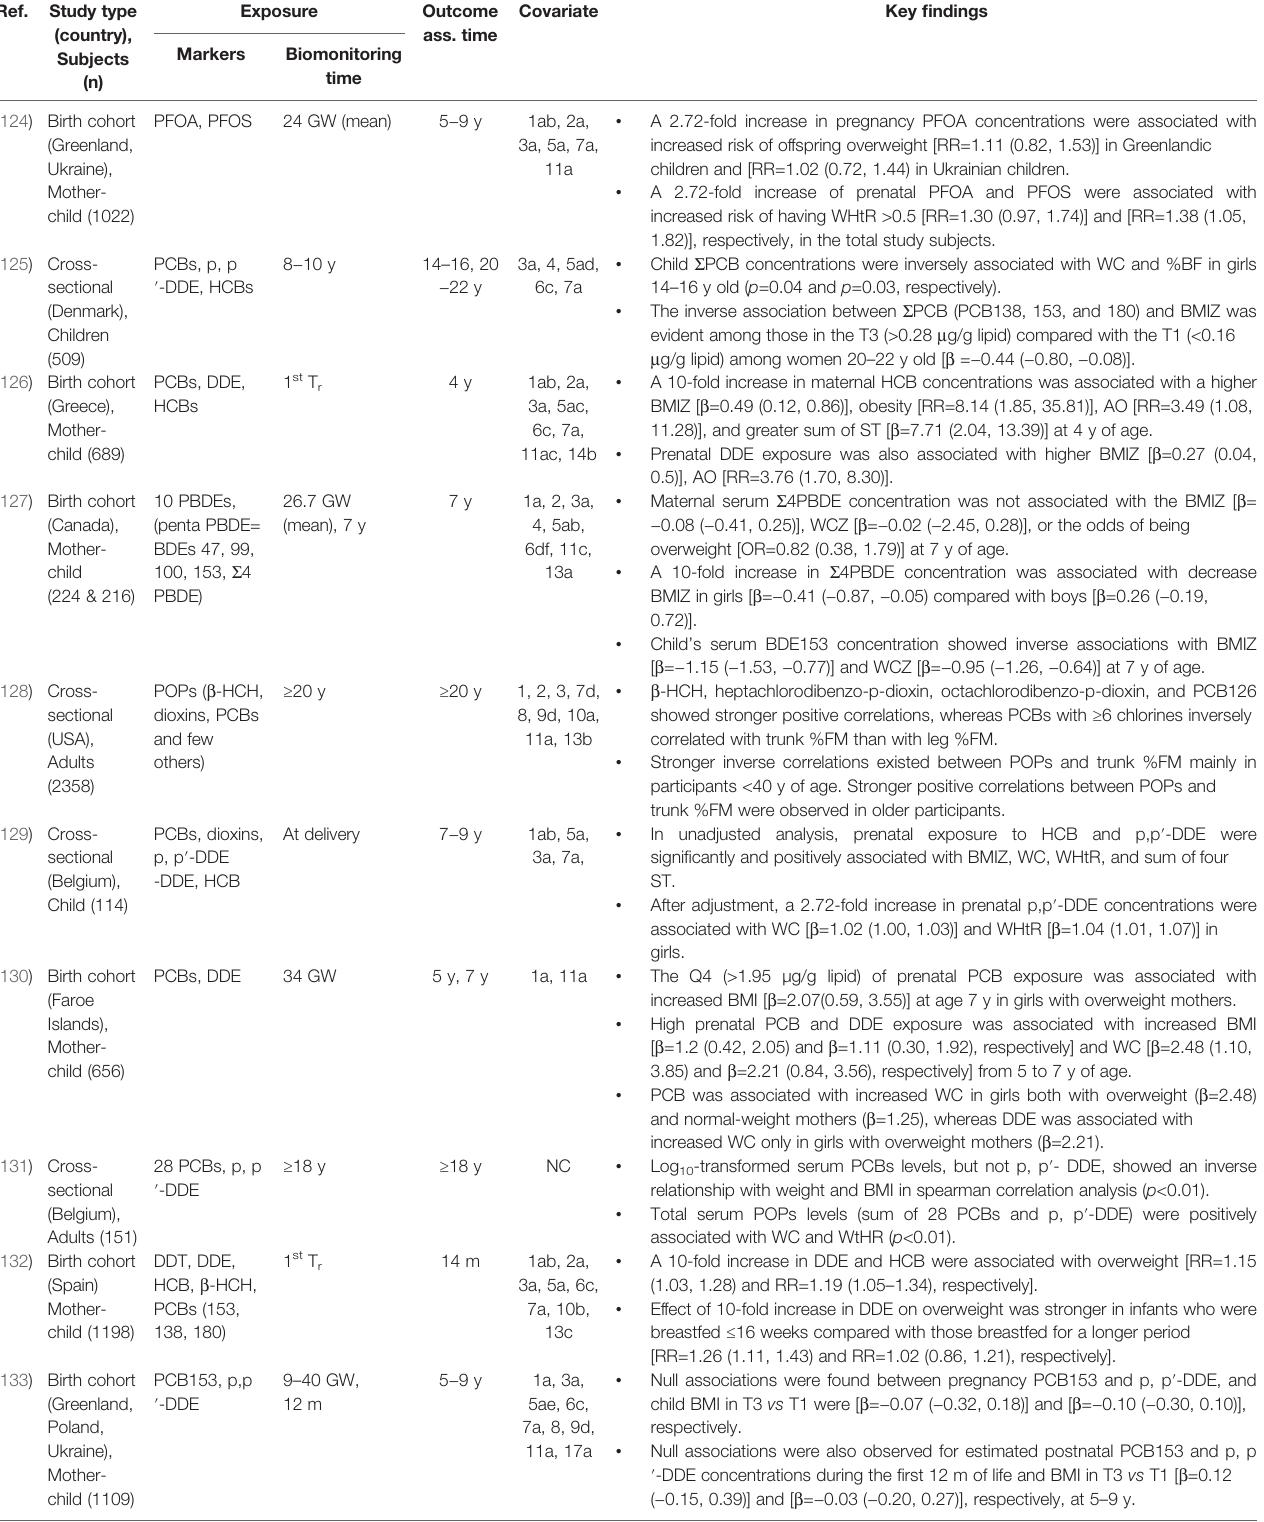
(125) Cross- Child S PCB concentrations were inversely associated with WC and %BF in girls (129) Cross- (cid:129) In unadjusted analysis, prenatal exposure to HCB and p,p ′ -DDE were (130) Birth cohort (cid:129) The Q4 (>1.95 µg/g lipid) of prenatal PCB exposure was associated with (131) Cross- NC (cid:129) Log 10 -transformed serum PCBs levels, but not p, p ′ - DDE, showed an inverse (133) Birth cohort Null associations were found between pregnancy PCB153 and p, p ′ -DDE, and